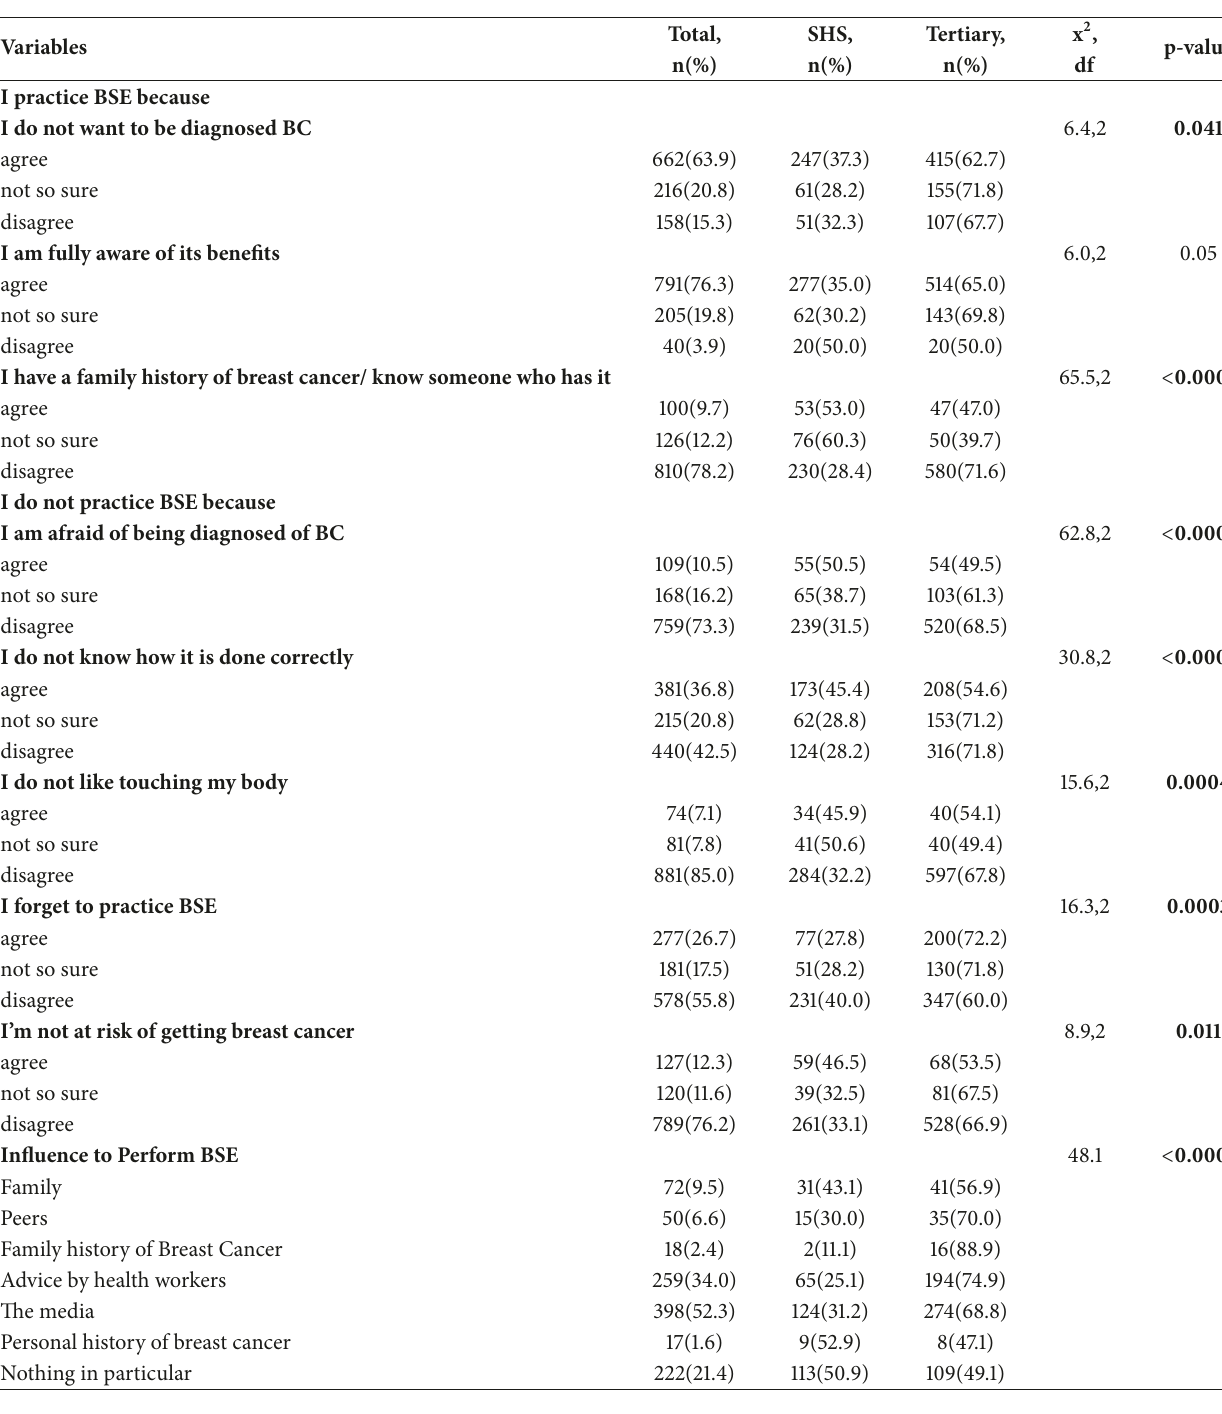
Table 5: Participants’ BSE practices stratified by their level of